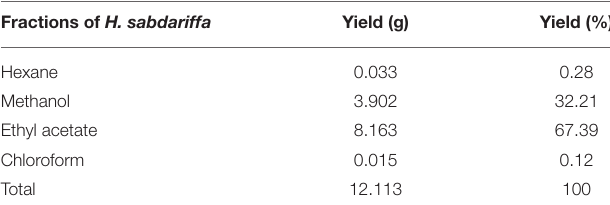
TABLE 1 | Yield of the respective organic solvent extracted fractions of Roselle ( Hibiscus sabdariffa ). Fractions of H.